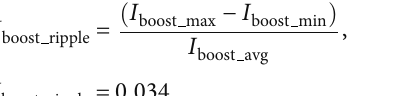
and bus voltage V boost